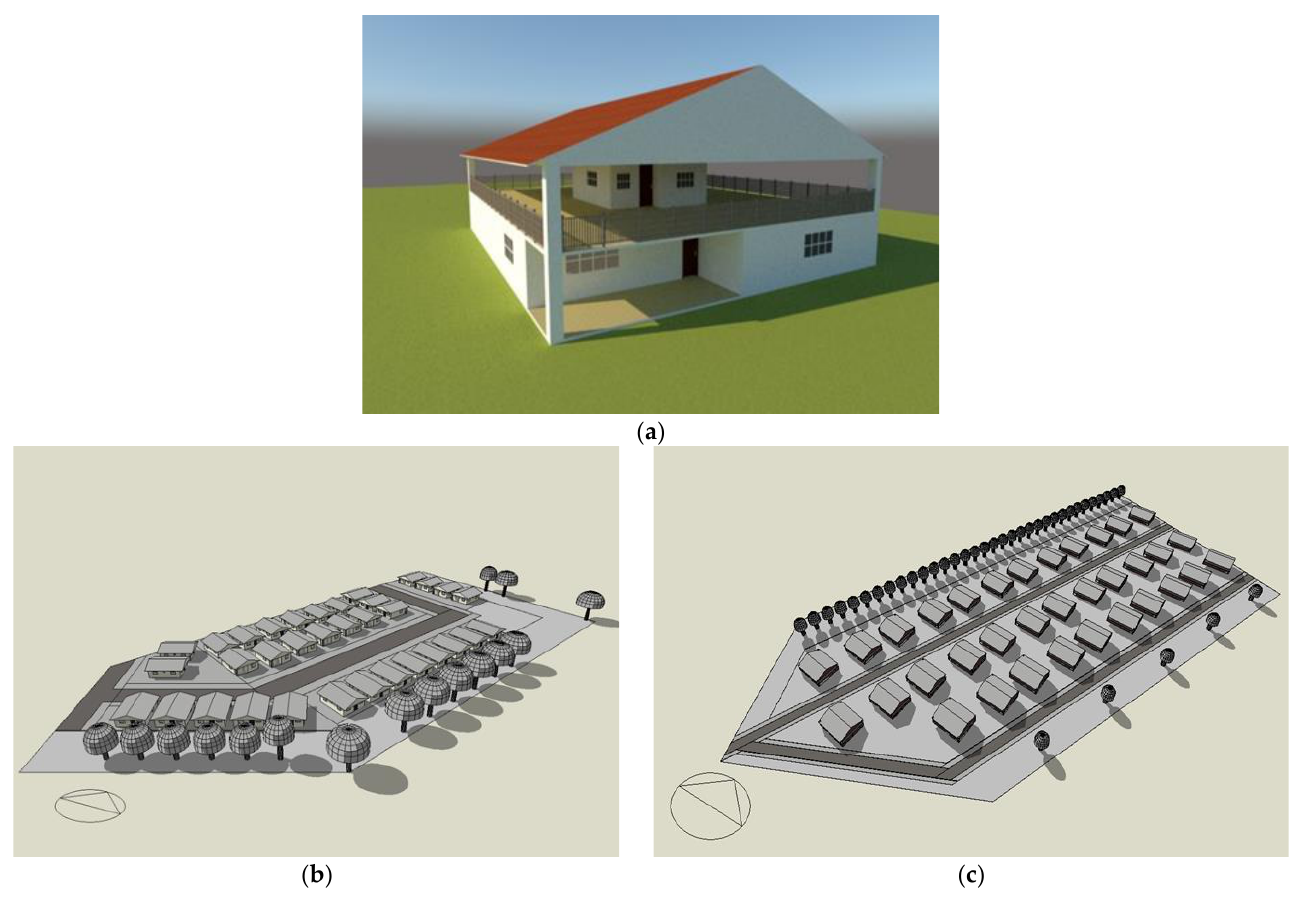
Figure 9. ( a ) Shape of the proposed building in SketchUp, ( b ) 3D model of the EC urbanization, and ( c ) 3D model of the RC urbanization in DesignBuilder software.